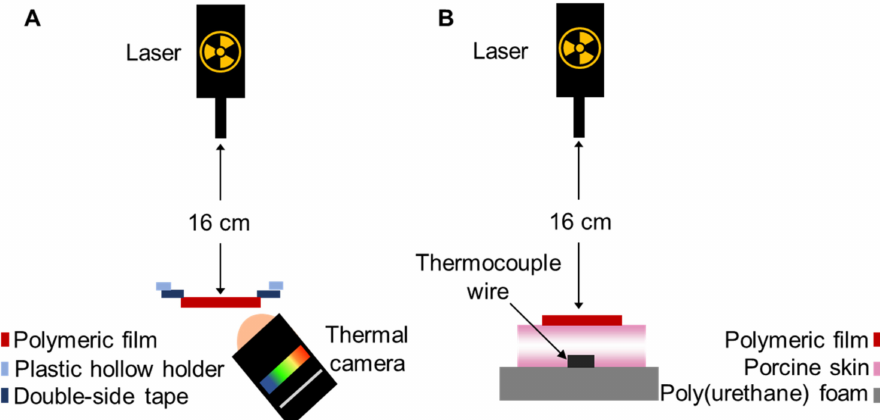
Figure 2. Experimental setup for thermal studies of gold-nanorod-loaded (GnR-loaded) films ( A ). Distance between laser and films was kept at 16 cm. Laser wavelength was 808 nm, with a power of 2W, and film irradiation lasted for 15 s. Experimental setup for thermal studies using neonate porcine skin ( B ). The distance between the laser and polymeric film was kept at 16 cm. Thermocouple wire was placed underneath the porcine skin. The laser wavelength was 808 nm, with a power of 2 W, and films irradiation lasted for 15